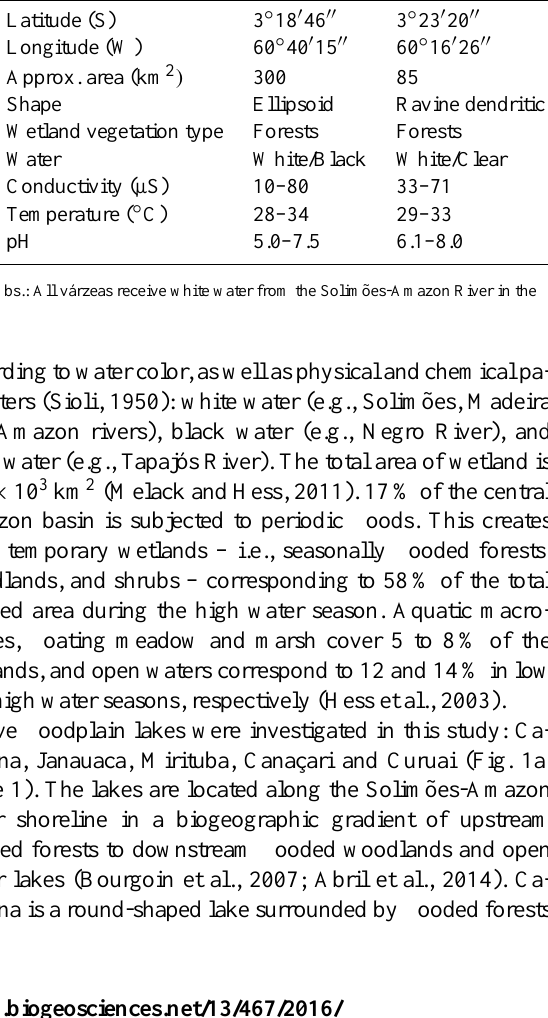
Ellipsoid Ravine dendritic Forests